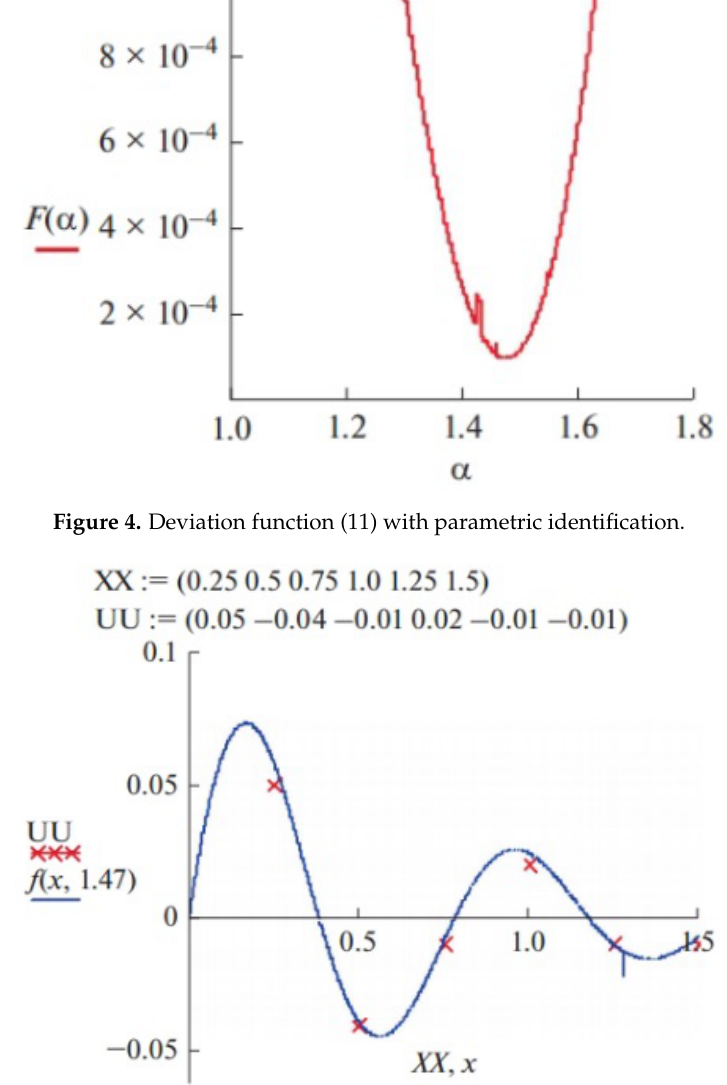
Figure 5. Comparison of experimental data with theoretical curve